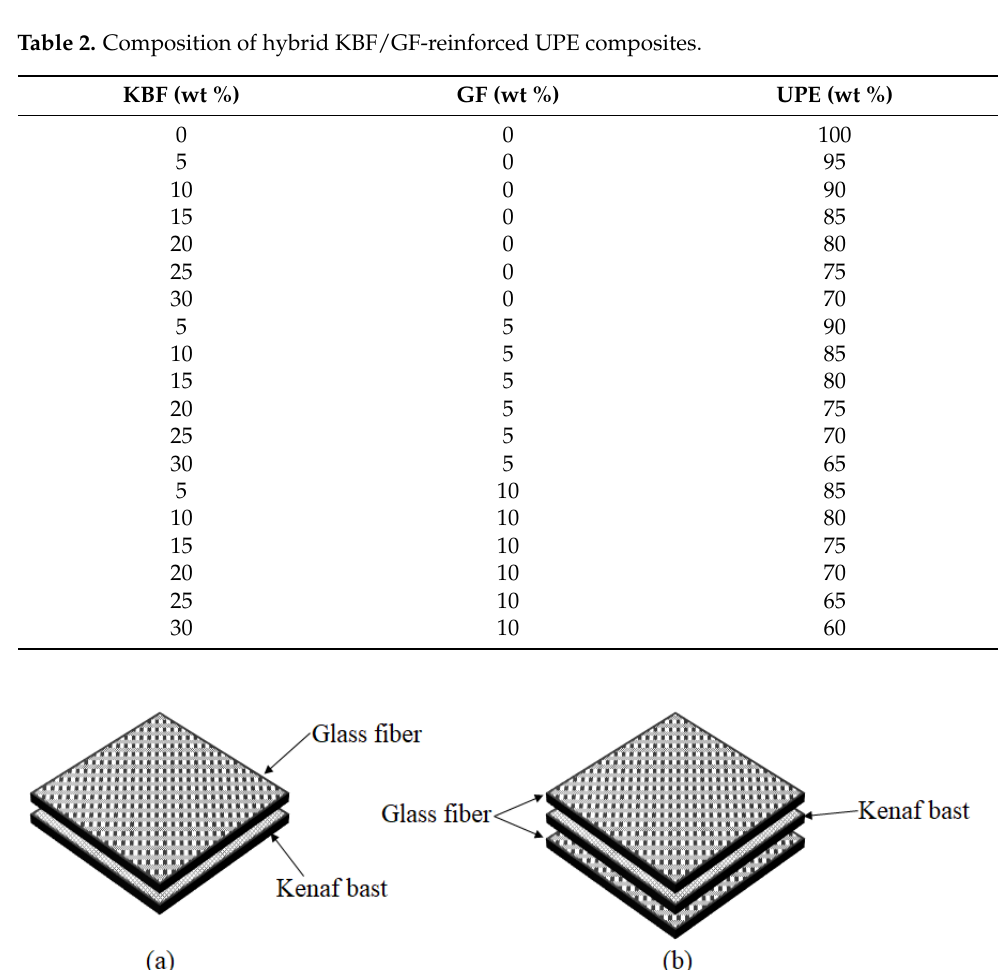
Figure 2. Sequence of ( a ) KBF + 5 wt % of GF and; ( b ) KBF + 10 wt % of GF for composite prepara-